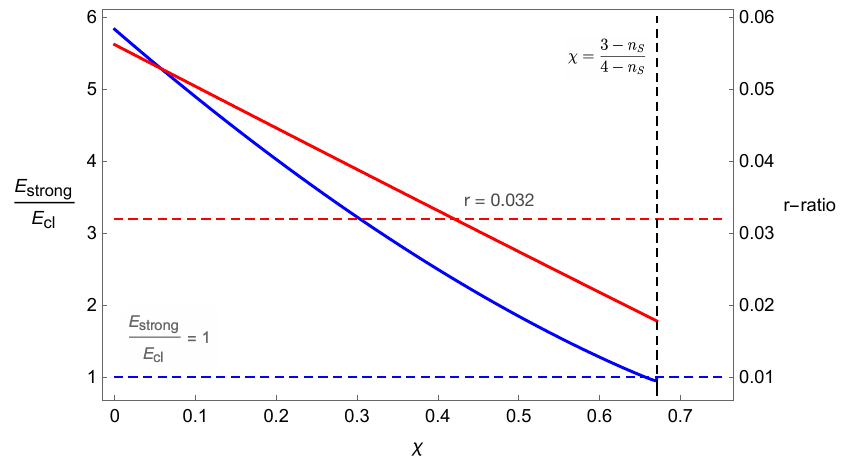
Figure 5 . The ratio E strong ( k ∗ ) /E cl ( k ∗ ) (blue line) and r -ratio (red line) as functions of χ for the central value n S = 0 . 9649 . The allowed range r < 0 . 032 and the unitarity bound E strong ( k ∗ ) /E cl ( k ∗ ) > 1 restrict the parameter space to the right lower part.